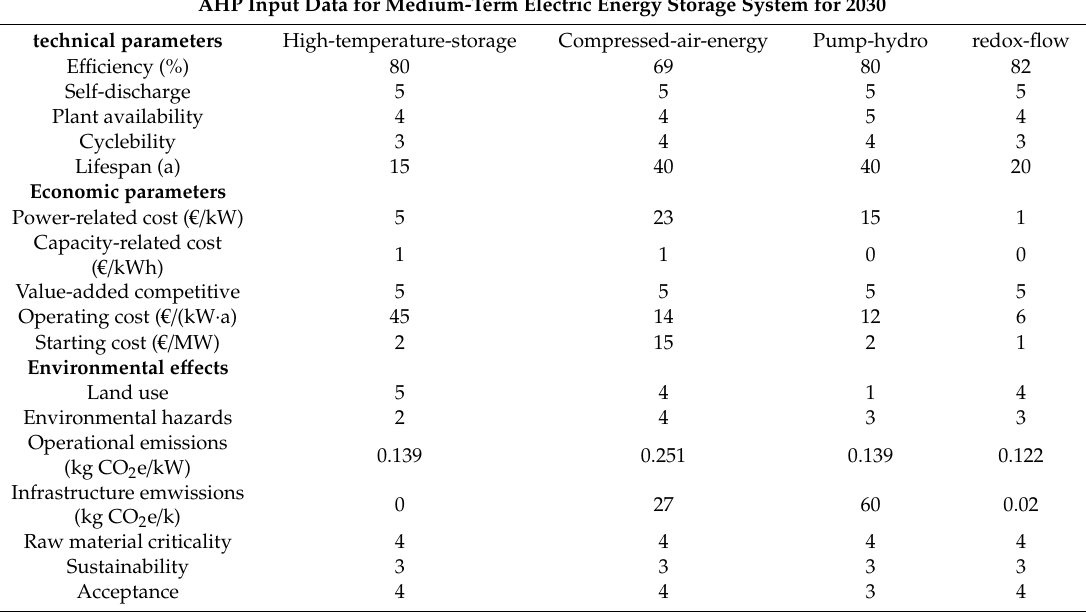
Table A6. AHP input data for medium-term EESS system for the years 2030, 2040, and 2050. The data used stems from